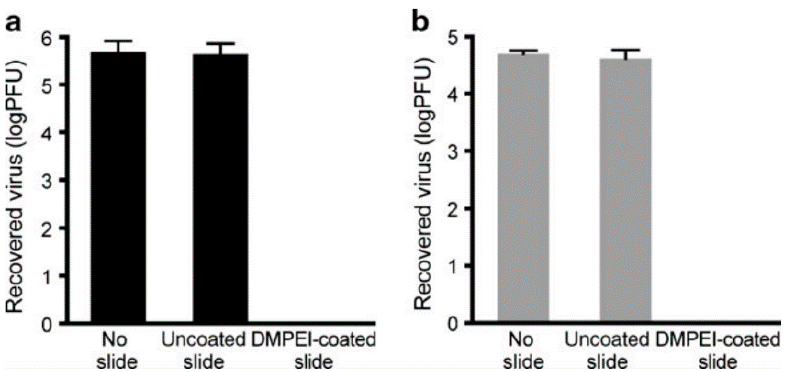
Figure 6. Tests results of N,N -Dodecylmethyl-PEI (DMPEI) coating on HSV-1 ( a ) and HSV-2 ( b ).